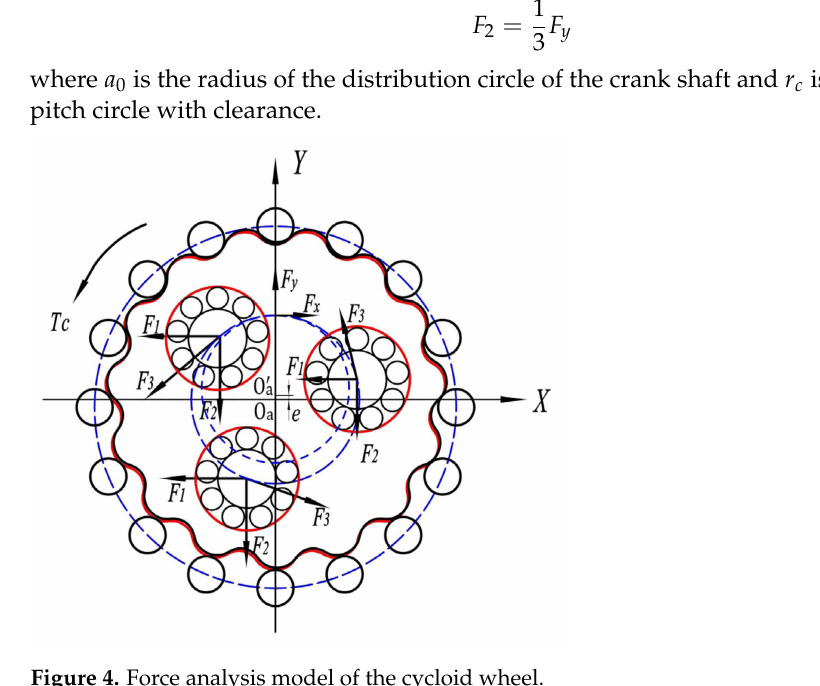
Figure 4. Force analysis model of the cycloid wheel. The needle roller bearing bears the force from the cycloid wheel and the crank shaft.